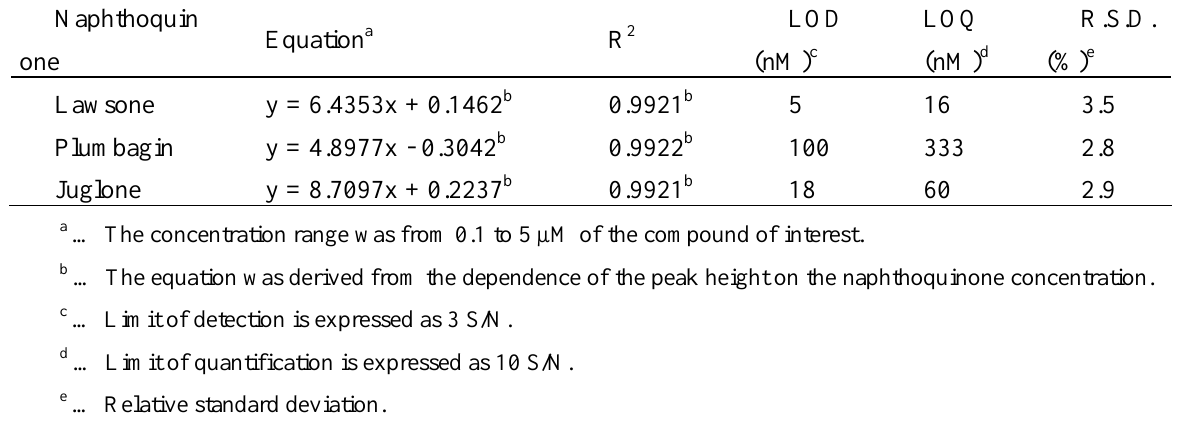
Table 1. Differential pulse voltammetric characteristics of the naphthoquinones of interest ( n = 5 ).